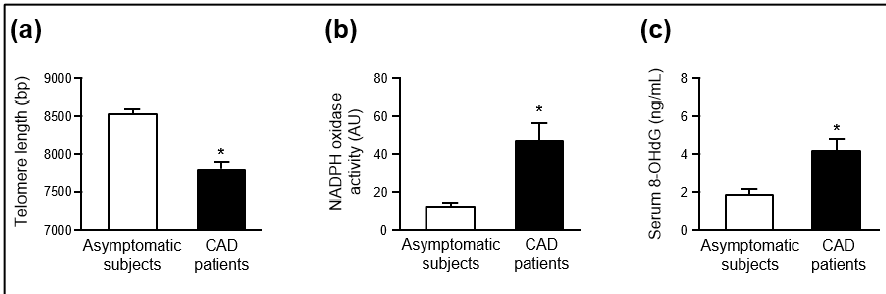
peripheral blood mononuclear cells, and ( c ) serum 8-OHdG levels in asymptomatic individuals ( n = 25) and CAD patients ( n = 25). * p < 0.05 compared with asymptomatic subjects after adjusting for age and sex. CAD, coronary artery disease. bp, base pairs; AU, arbitrary units; 8-OHdG,